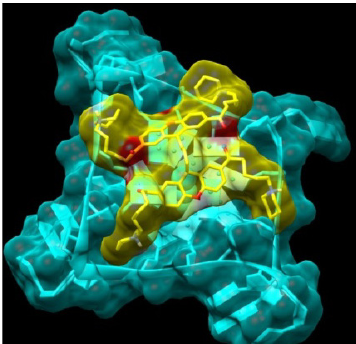
Figure 4. Model obtained for the complex between the Bridge Dimer ( 11 , yellow atom-type) and the monomeric G-quadruplex (light blue).